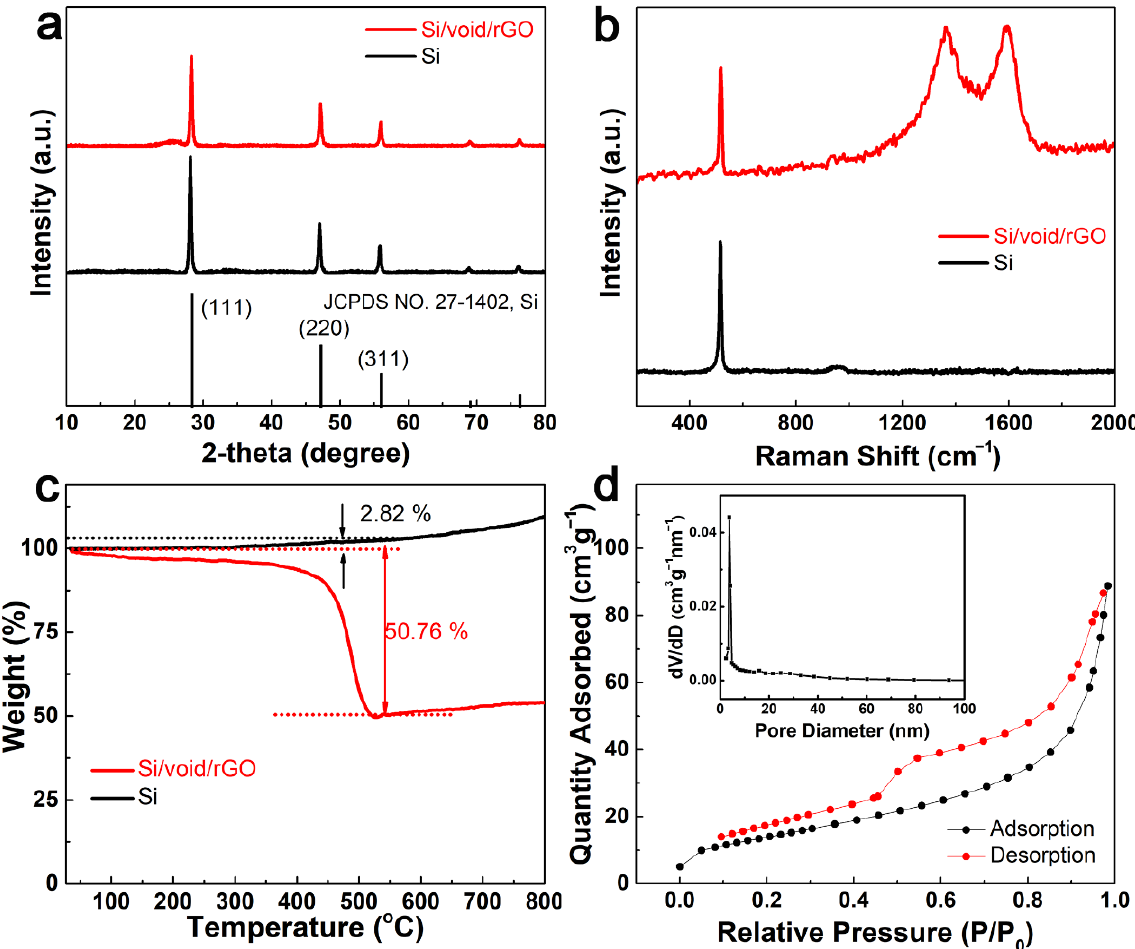
Figure 3. ( a ) XRD patterns and ( b ) Raman scattering spectra of free-standing Si/void/rGO electrode and Si; ( c ) TG curve and ( d ) N 2 adsorption–desorption isotherm and the corresponding pore size distribution of free-standing Si/void/rGO electrode.